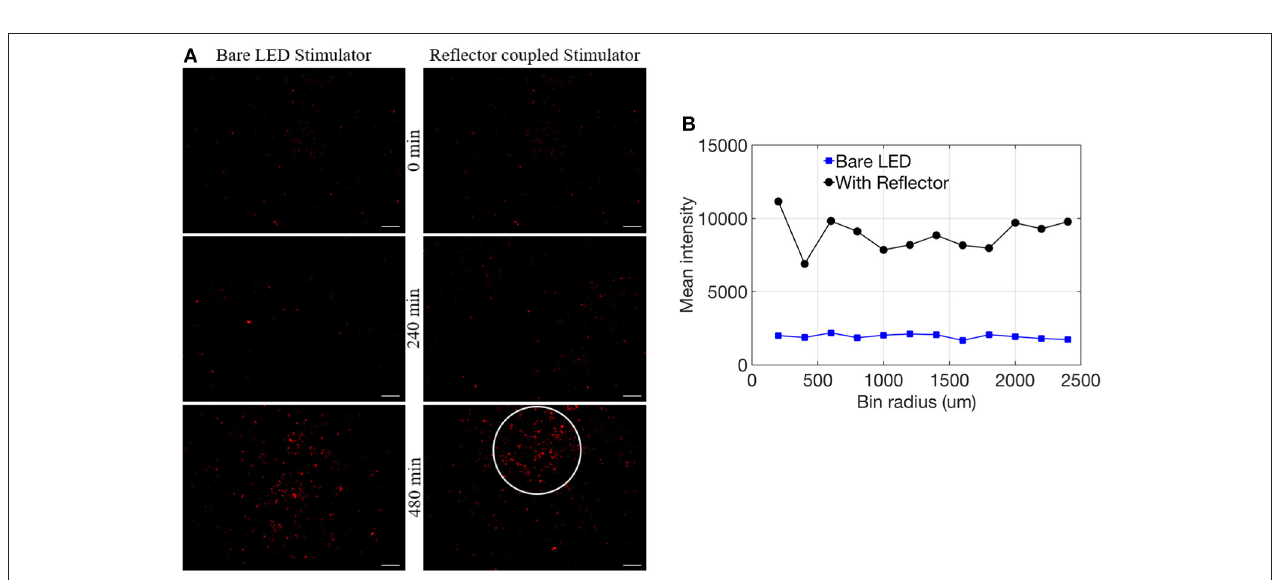
FIGURE 6 | (A) Comparison of bare LED stimulator and reflector coupled stimulator fluorescence of RFP reporter for 0, 240, and 480min (scale = 1mm). (B) Mean intensity data with respect to bin radius ( n = 1).